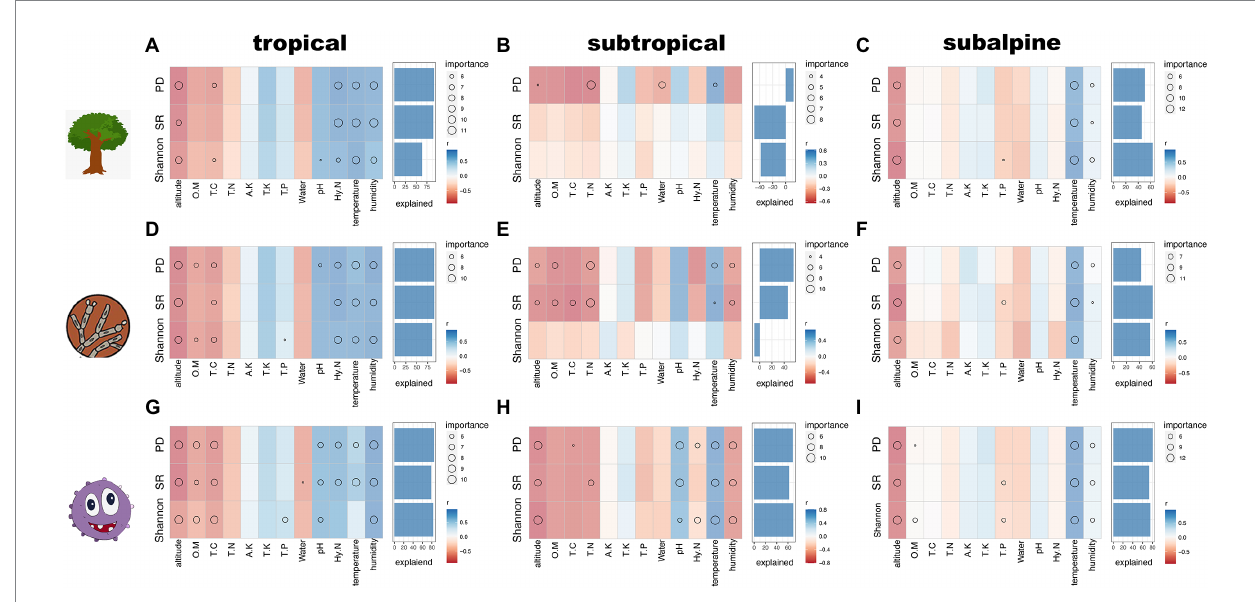
FIGURE 3 Analysis of environmental factors and diversity indexes in three climatic zones using random forest. A - C : tree species; D - F : fungal species; G - I : bacterial species; OM: soil organic matter content; TC: total carbon; TN: total nitrogen; HN: hydrolysable nitrogen; TP: total phosphorus; TK: total potassium; AK: available potassium; pH: soil pH; water: soil moisture content; temperature: air temperature; humidity: air